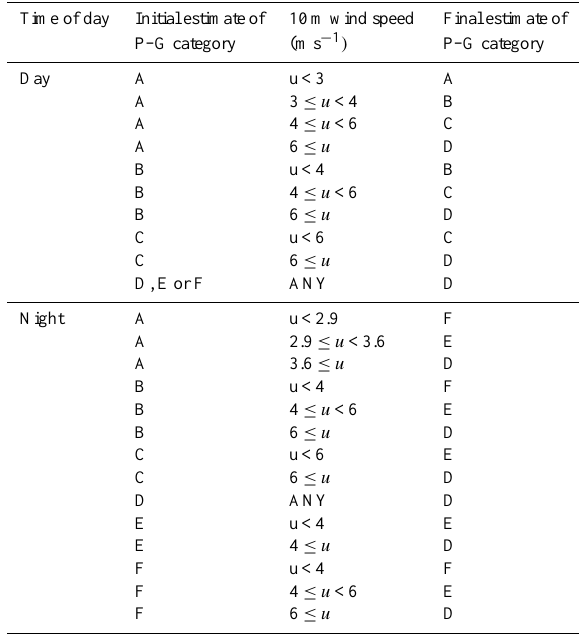
Table 3. Wind speed adjustments to determine final estimate of P–G turbulence